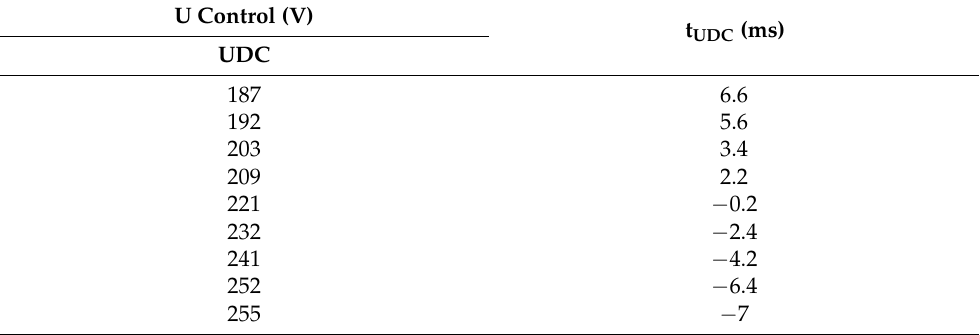
Figure 13 represents the dependency of parameter t UDC on the DC voltage supply on the disconnection of a circuit